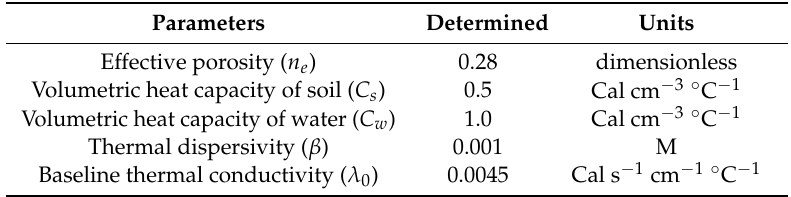
Table 1. Physical and thermal parameters of the soil and water used for water flux rates calculation by using analytical solution for heat and transport Equation